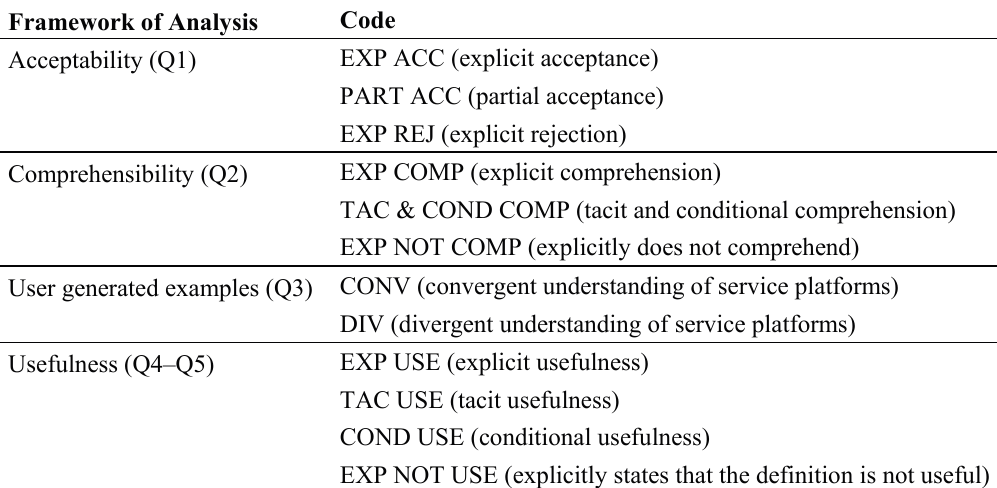
Table 2. Service Platform